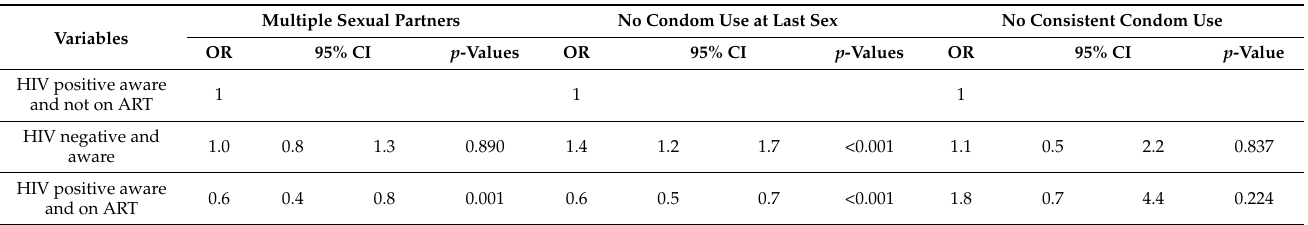
Table 3. Risky sexual behaviour variables by HIV status and ART exposure among individuals 15 years older, South Africa 2017